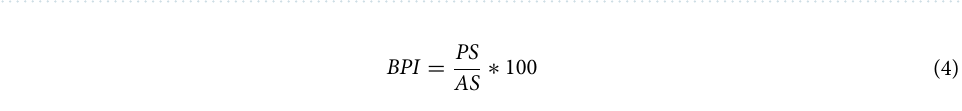
Figure 1. Topographic maps of relative power (%) in delta [1–4] Hz, theta [4.5–7.5] Hz, alpha [8–12] Hz, and beta [13–30] Hz bands, during OE standing and OE arms up , averaged from 14 controls (CTRL) (first row), 10 adolescents with AIS with right main curve (second row) and 4 adolescents with AIS with left main curve (third row). The fourth and the fifth rows represent p -maps derived from the Wilcoxon rank sum test (adolescents with AIS with right main curve: AIS-R vs. CTRL; adolescents with AIS with left main curve: AIS-L vs. CTRL). Statistical results were highlighted with (+) for p < 0.05